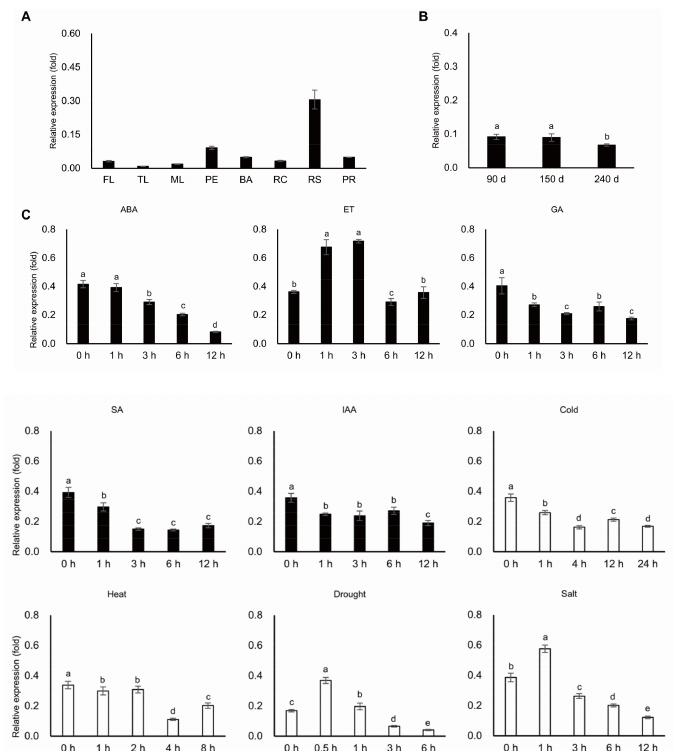
Figure 2. Transcription profiles of MeERF72 . ( A ) Expression profile of MeERF72 in different organs of cassava plant. F: flower, TL: tip leaf, ML: mature leaf, P: petiole, SR: stem rind, RC: root cortex, RS: root stele, PR: primal root; ( B ) Expression profile of MeERF72 in three growth stages of storage root; d: day; ( C ) Transcription profiles of MeERF72 respond to abscisic acid, ethylene, giberellin,